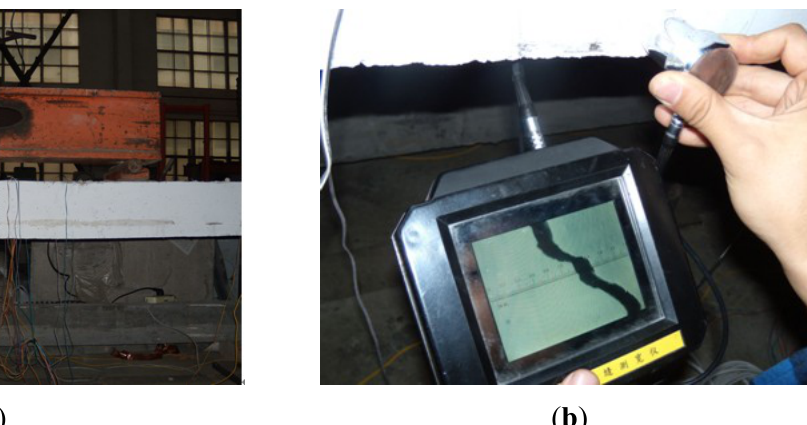
Figure 13. Photos of cracks distribution and measurement. ( a ) Crack distribution; and ( b ) Measuring crack